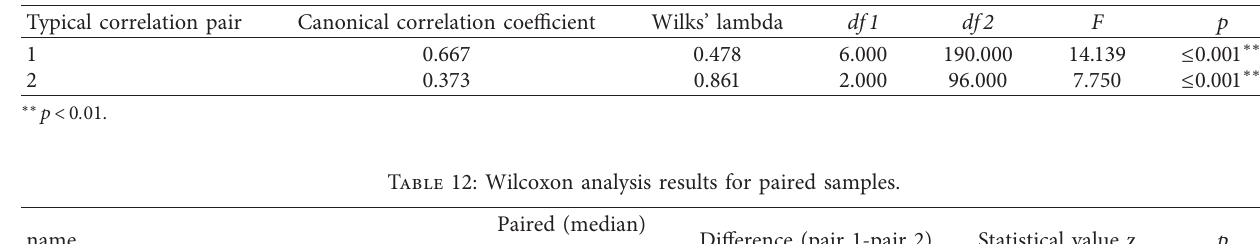
Table 11: Typical correlation coefficient and significance.